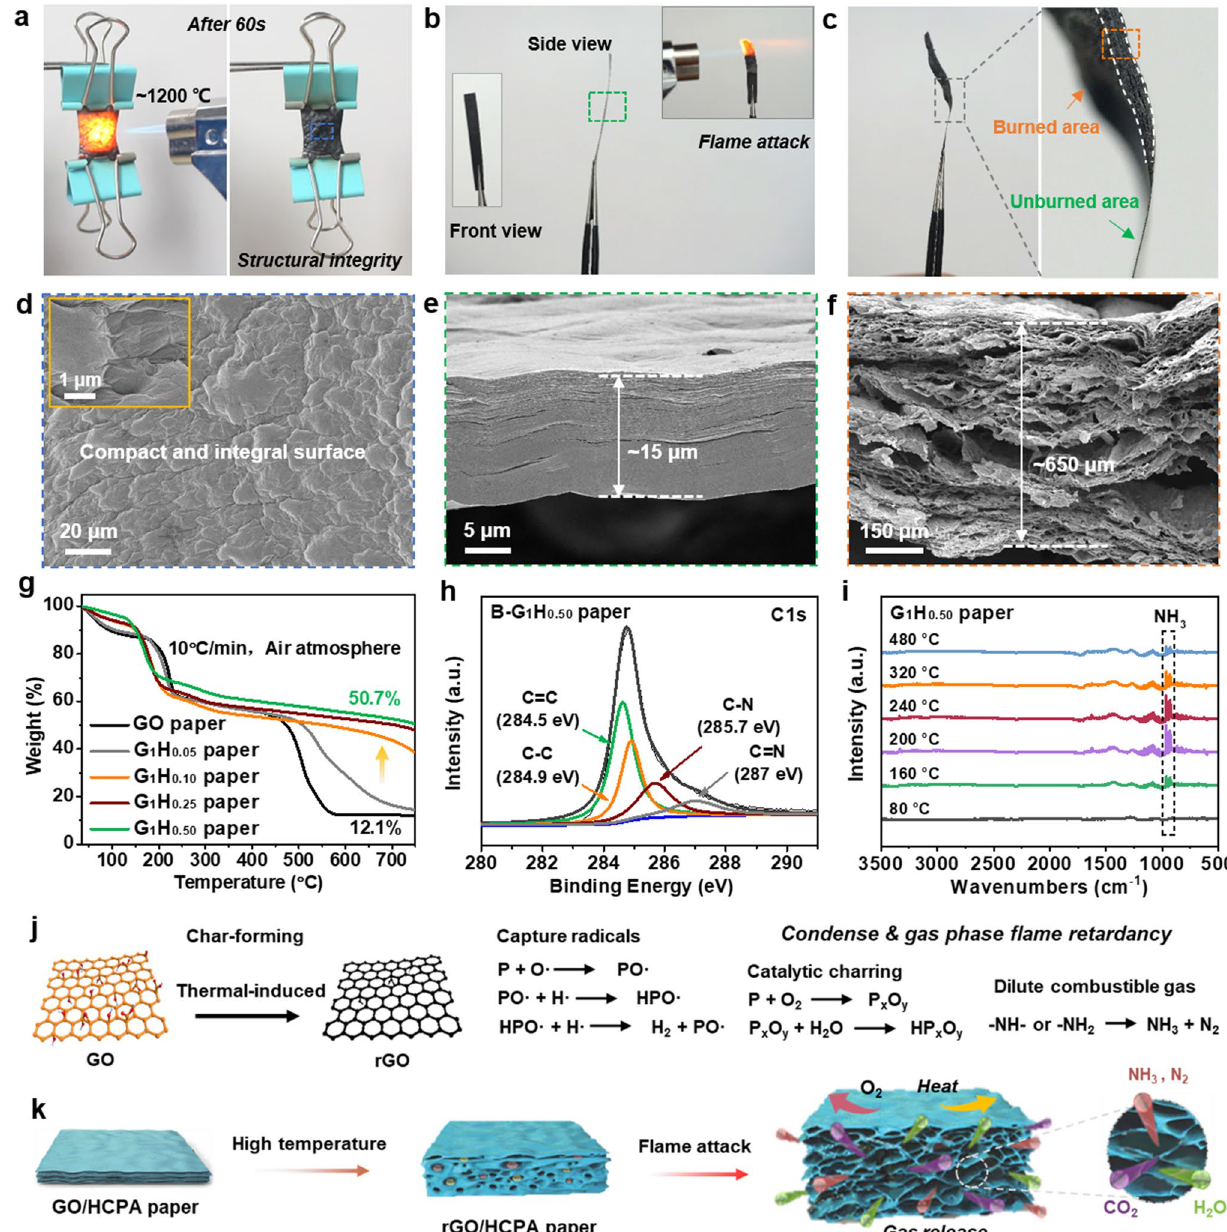
Fig. 3 Flame retardant performance and its mechanisms. a – c Digital photographs and d – f SEM images of the G 1 H 0.50 paper before/after being exposed to the butane blowtorch flame (~ 1200 ℃ ) for 1 min, the almost unchanged original shape, structural integrity, and obvious increase in thickness, showing excellent flame retardancy and thermal stability, exceptional intumescent effect of the GO/HCPA paper. g TGA results of various GO/HCPA papers. h XPS C 1 s spectra of G 1 H 0.50 paper after being burned. i TG‑IR results of G 1 H 0.50 paper. j Multiple flame‑retardant mechanism, and k intumescent process of the GO/HCPA paper under high temperature and flame attack